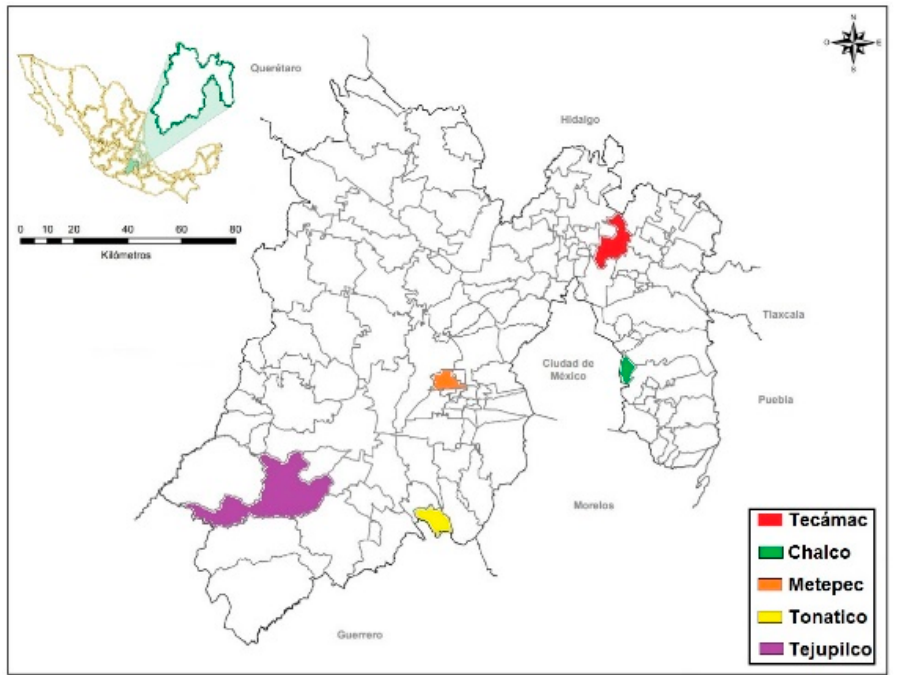
Figure 2. Distribution of five meteorological stations in the state of Mexico, Mexico, used to estimate the greenhouse thermal effectiveness.